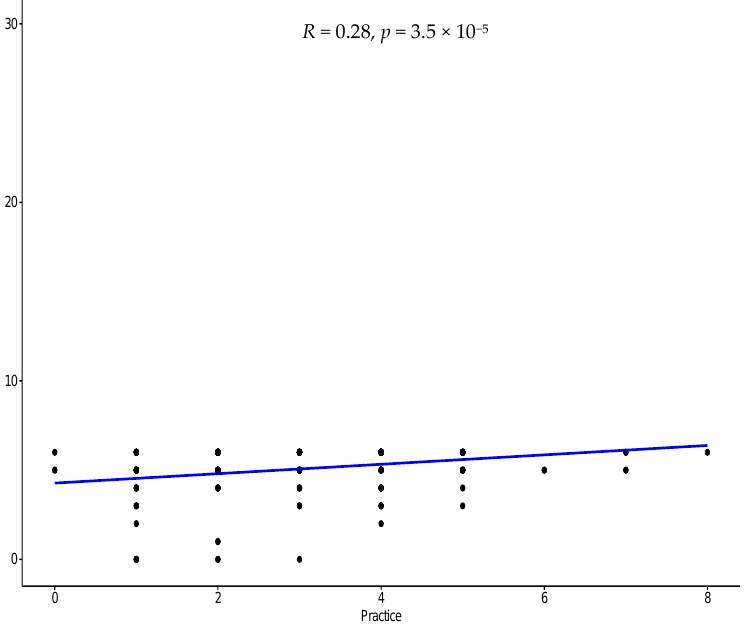
Figure 2. Scatter plot with regression line to show the correlation between knowledge and practice. There is a statistically significant positive weak correlation between knowledge and practice (R = 0.32).